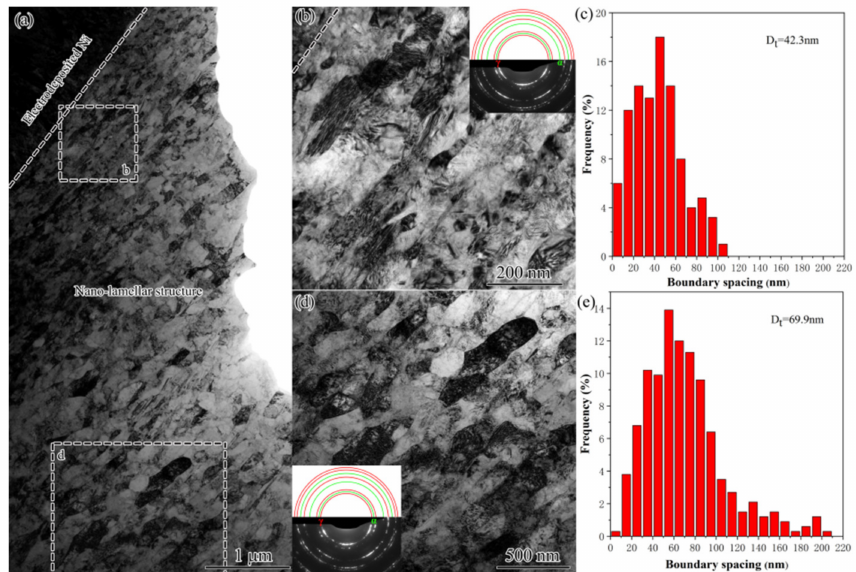
Figure 11. TEM observations ( a , b , d ) and the corresponding histograms of boundary spacing ( c , e ) of the GNS in USRT AISI 304 stainless steel sample. ( b , d ) The enlarged image of the rectangle marked area in ( a ). The SAED pattern together with theoretic circles for fcc γ and bcc α was